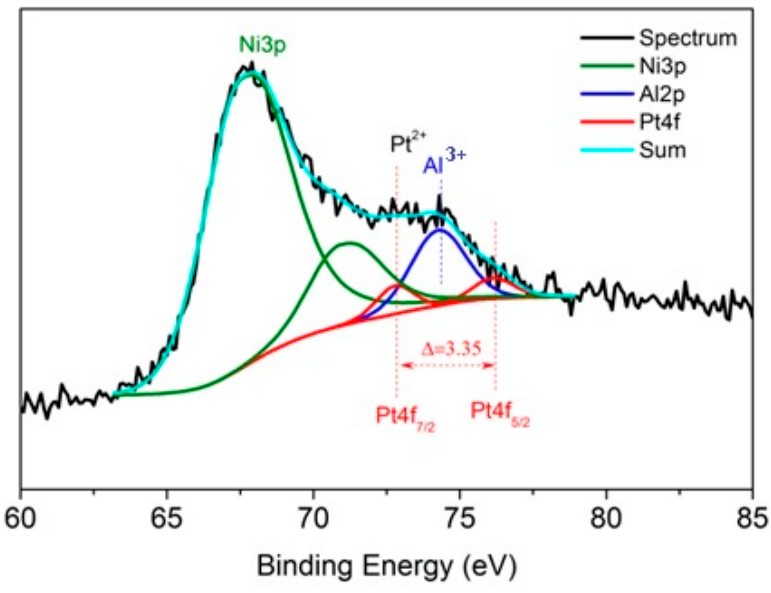
Figure 11. XPS spectra of 10Ni1Pt/Z-h zeolite.